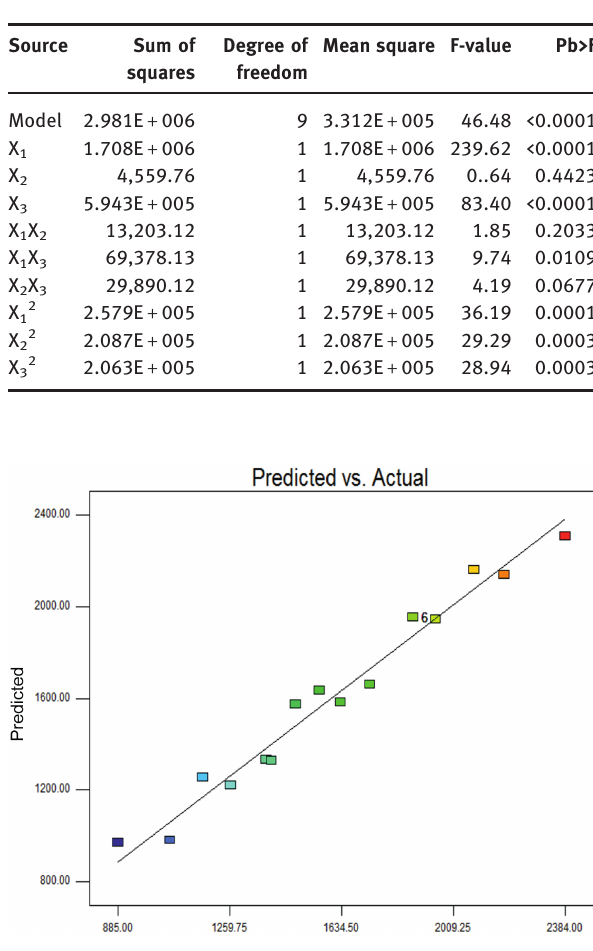
Table 2: Experimental design matrix and results. Table 3: Analysis of variance for the iodine number.